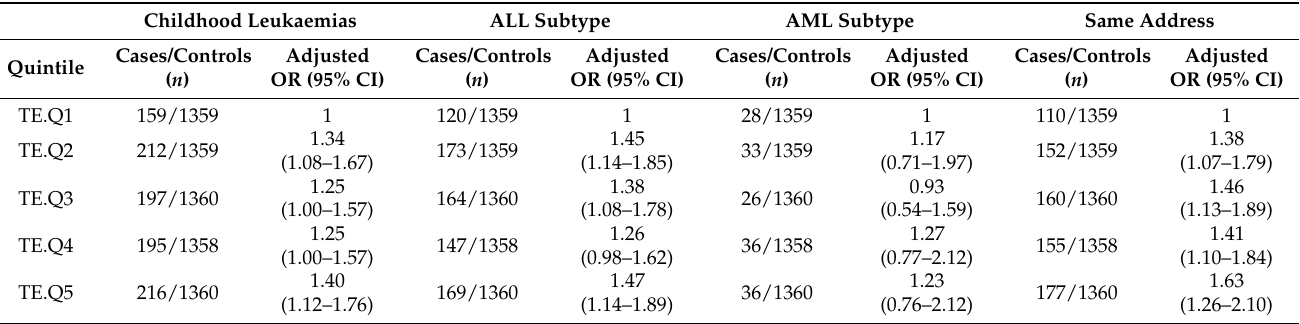
Table 3. Traffic exposure and UGS exposure ORs extracted from the final adjusted regression model for overall childhood leukaemia, ALL and AML subtypes, and identified cases with same address at birth and diagnosis results. Adjusted models for sex, year of birth, SES, and activity